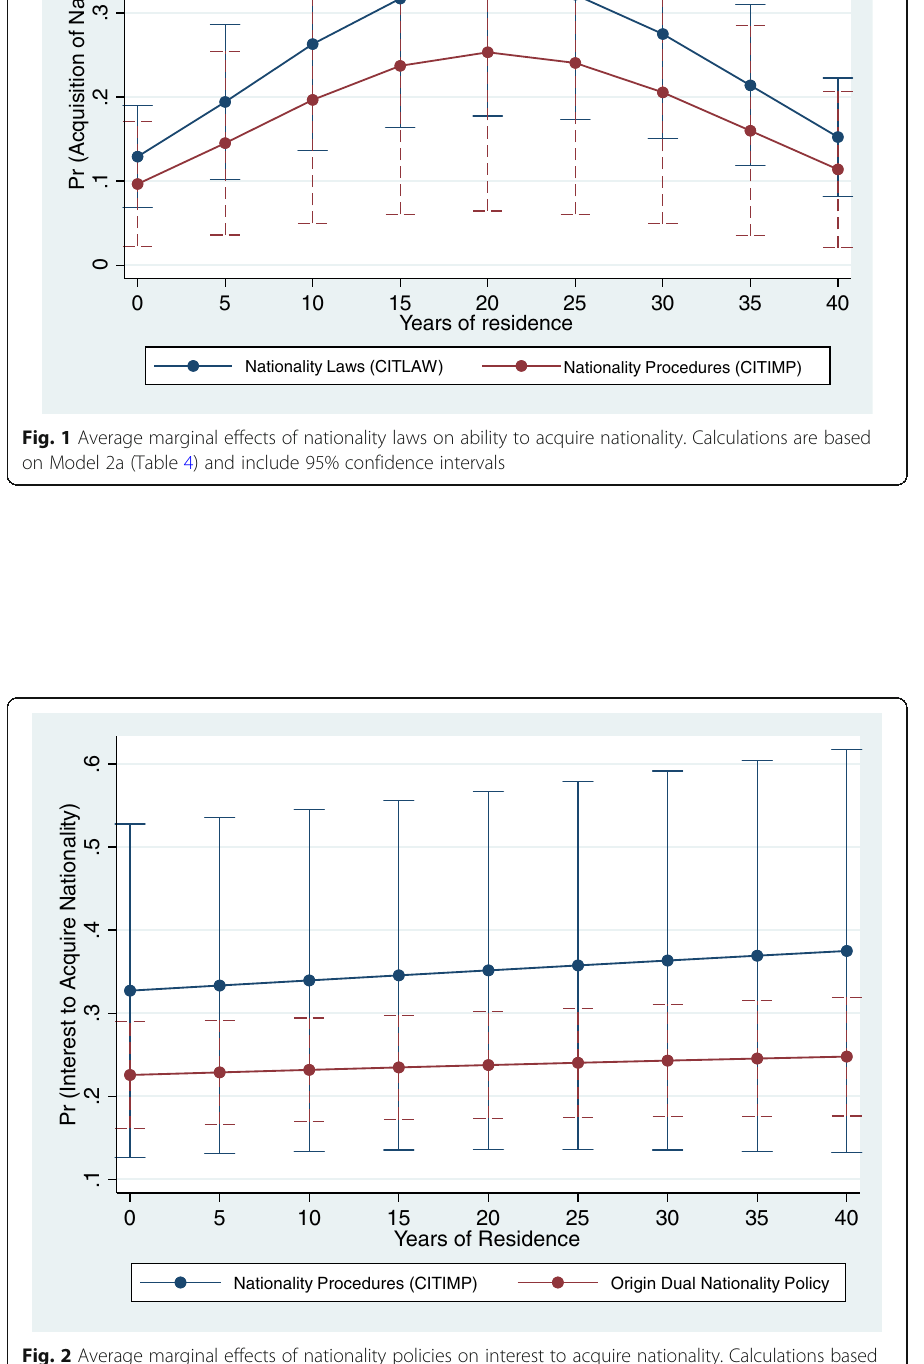
Fig. 2 Average marginal effects of nationality policies on interest to acquire nationality. Calculations based on Model 2b (Table 4) and include 95% confidence intervals